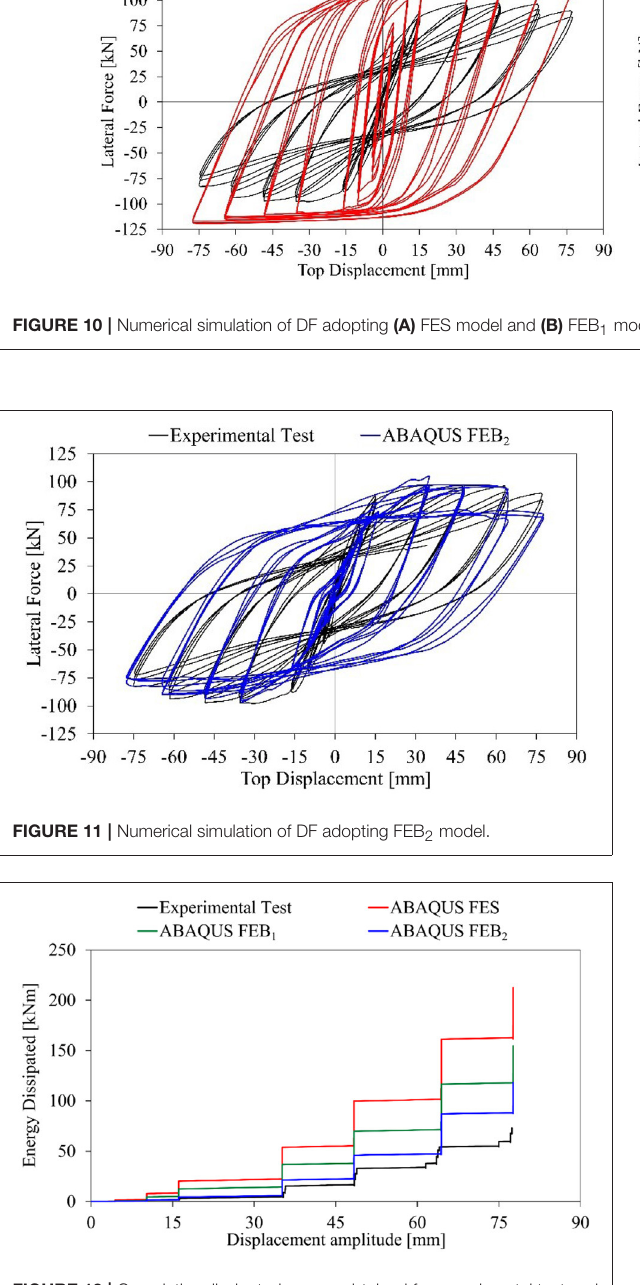
loops obtained for high displacement amplitude are significantly influenced by the hysteretic behavior of the steel, which is not characterized by pinching.